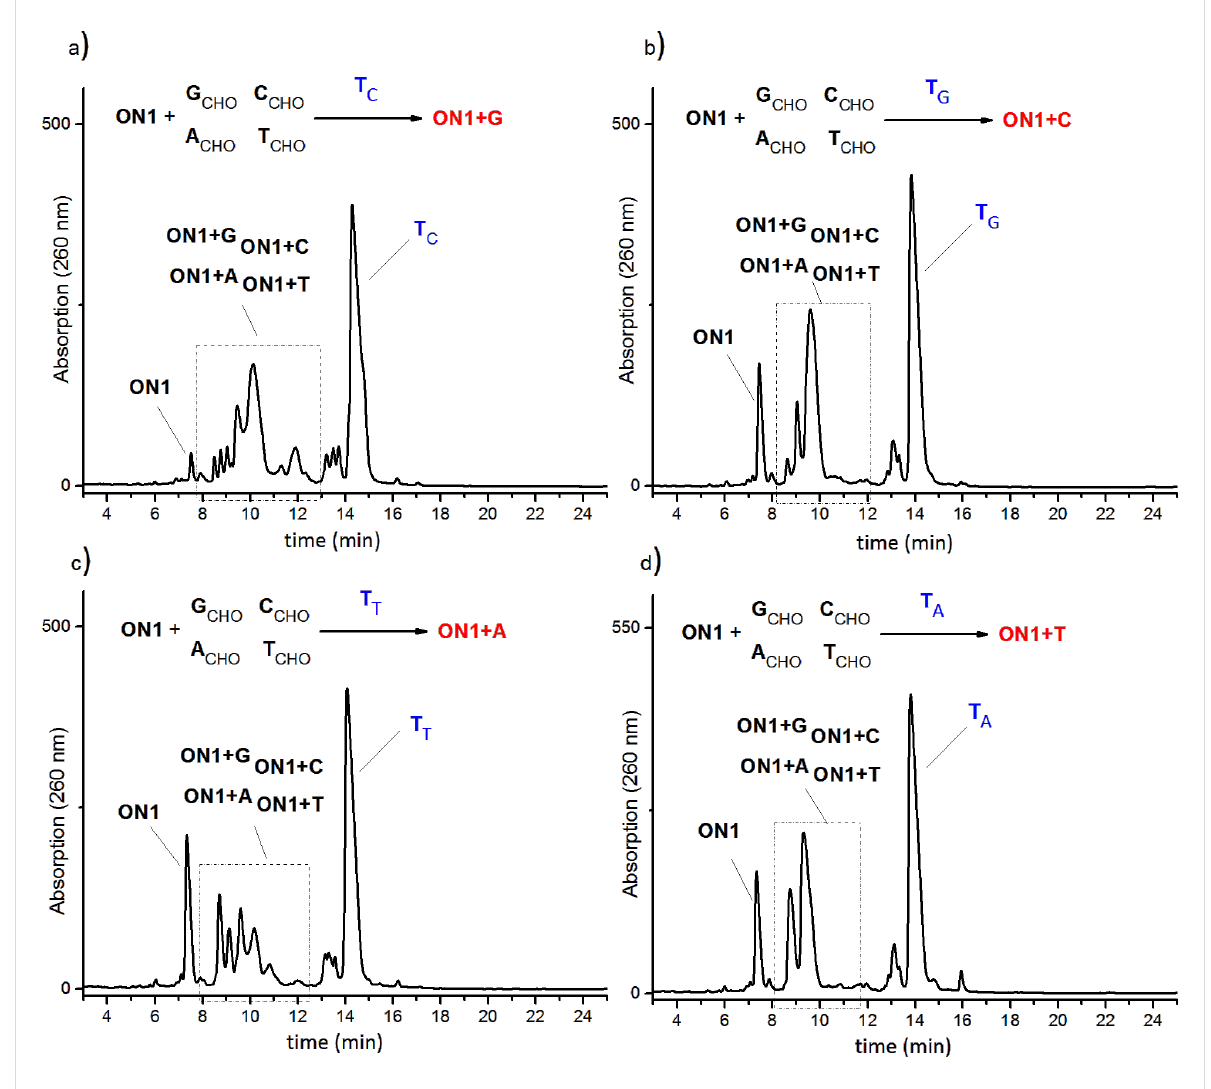
Figure 4: Representative HPLC chromatograms for the mixture containing ON1 and four nucleobases in the presence of a DNA-template: a) T C ; b) T G ; c) T T ; d) T A . The chromatograms were performed after reductive amination of the samples (for more details see Supporting Information File